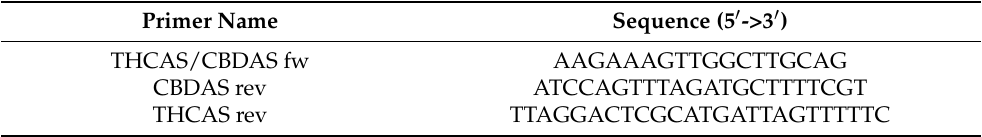
Table A1. Primer sequences used for chemotype